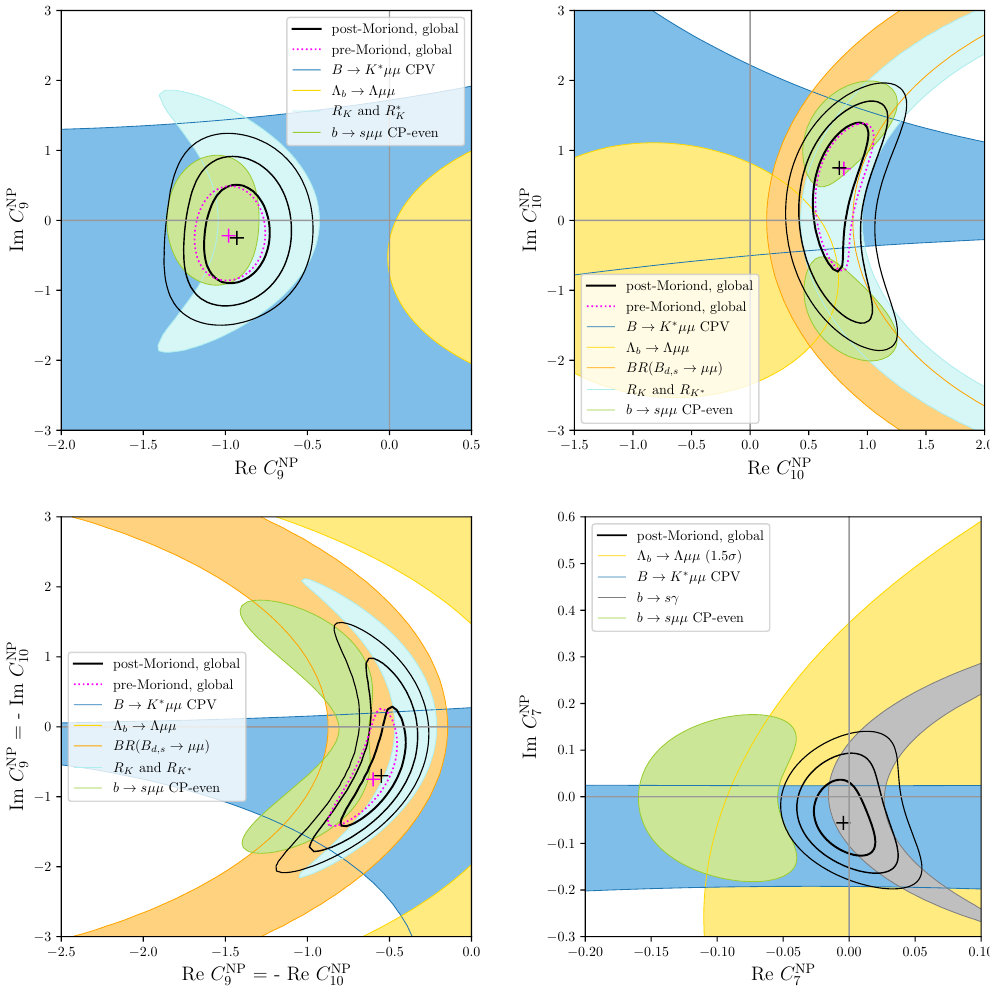
Figure 1 . 1 σ constraints on the NP Wilson coefficients from Λ b → Λ µµ (yellow), b → sµµ (green), (light blue), B (orange) and B → K ∗ µµ CPV (dark blue). Pre- and b → sγ (grey), R s → µµ K/K ∗ post-Moriond 2021 global-fit regions are denoted in dotted purple (1 σ only) and solid black (1, 2 and 3 σ ). The corresponding crosses indicate the best-fit point. Pre- and post-Moriond global-fit contours exactly overlap in the C case (last 7